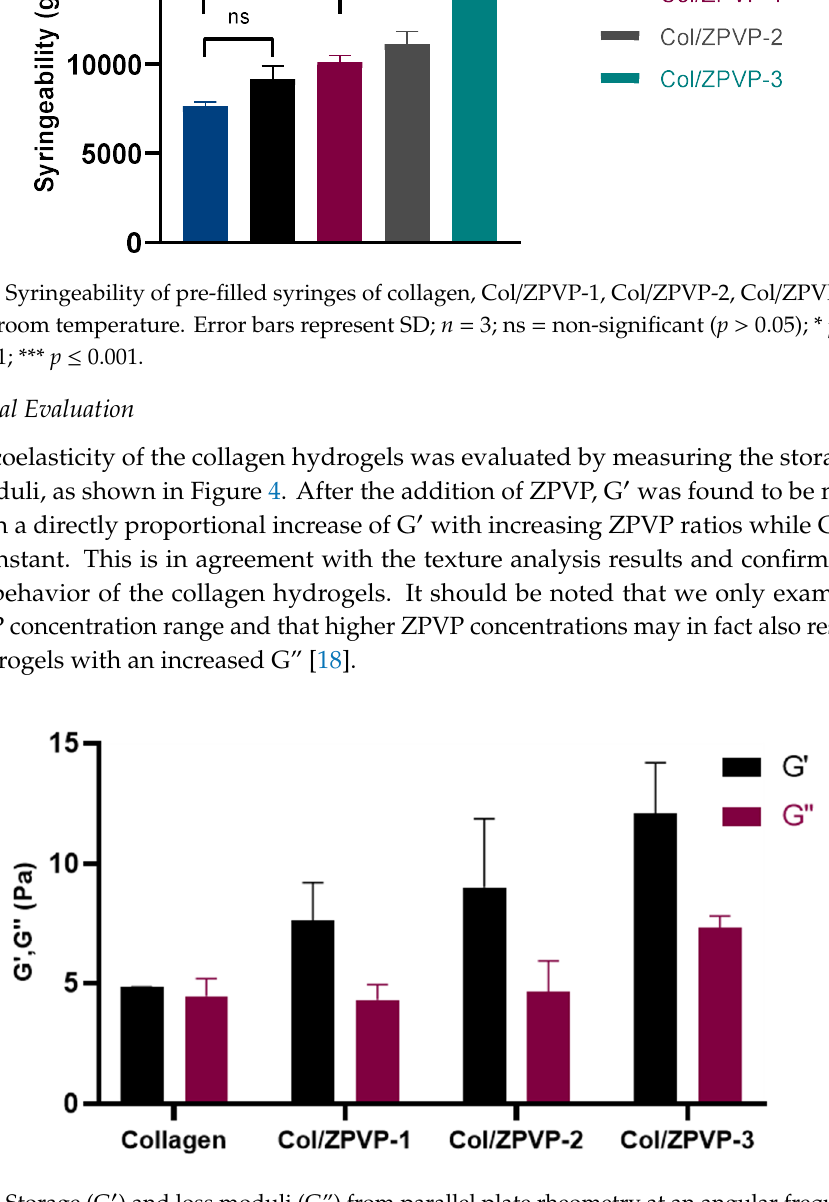
Figure 4. Storage (G’) and loss moduli (G”) from parallel plate rheometry at an angular frequency of 25 rad/s under 1% strain at room temperature. Error bars represent SD, n = 3.